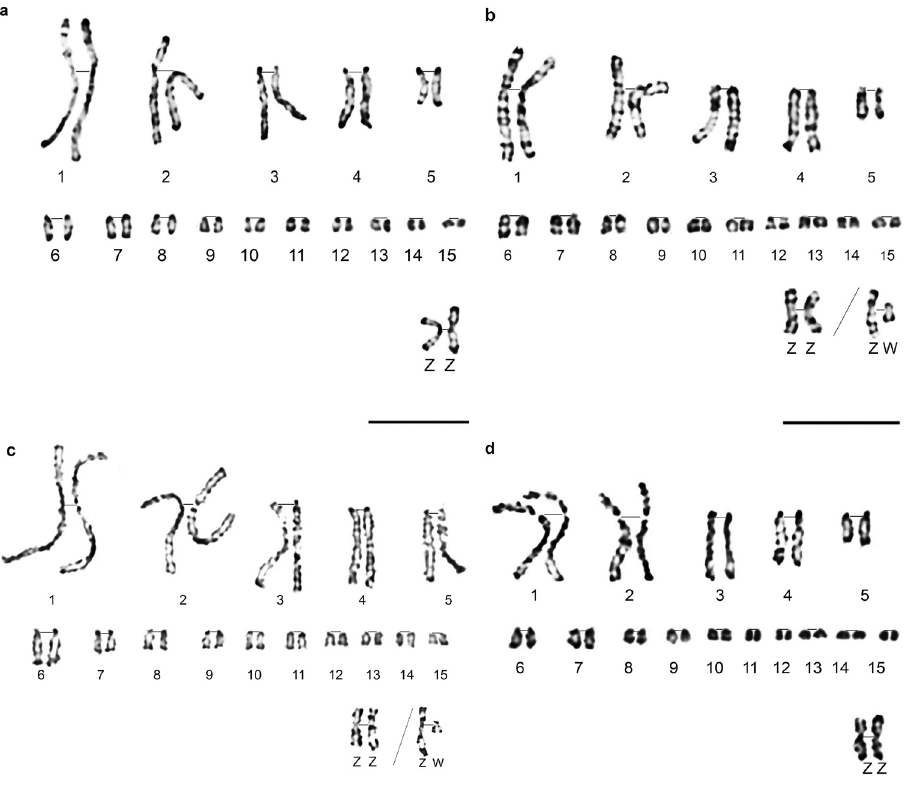
Figure 2. Partial karyotypes of A. barbara in GTG bands ( a ), A. barbara in RBG bands ( b ), A. chukar in GTG bands ( c ), and A. chukar in RHG bands ( d ) . Gonosomes Z W are classified apart. Scale bars: 5